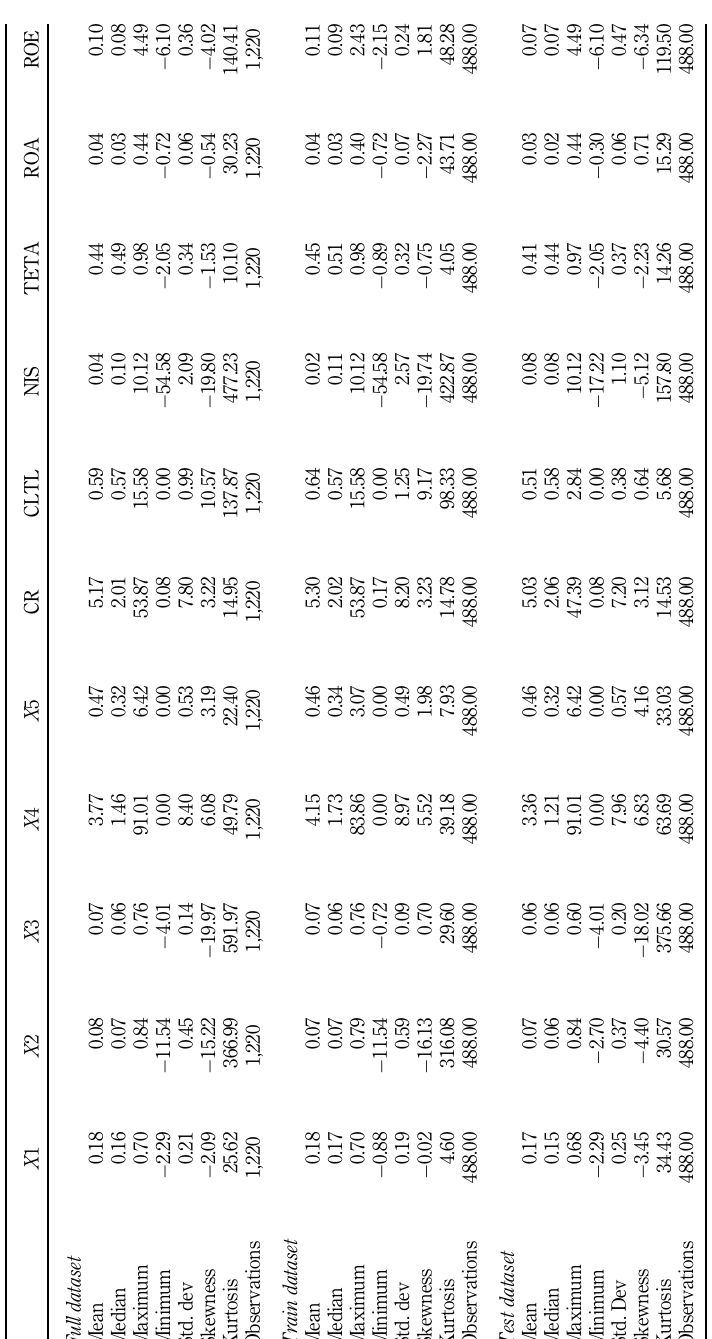
full datasets, train dataset and test